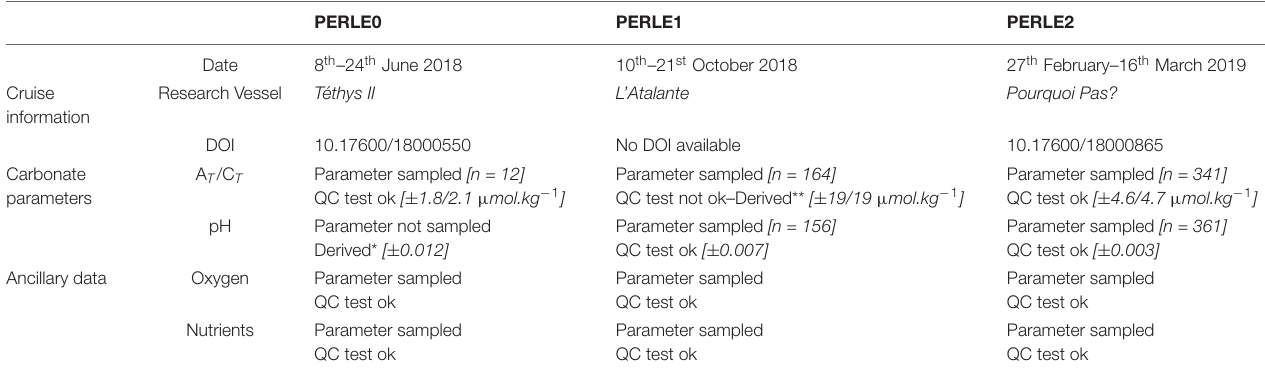
TABLE 1 | Summary of the cruise information and the parameters measured during each PERLE cruises including availability, number of samples (n) and their associated accuracy. PERLE0